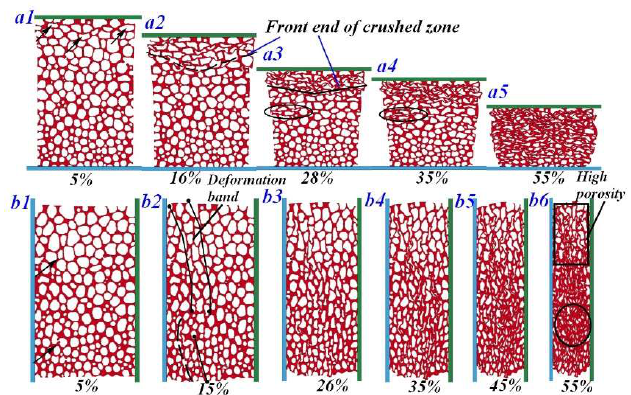
Figure 13. Numerical deformation behavior of FGs under ( a ) LC and ( b ) TC.